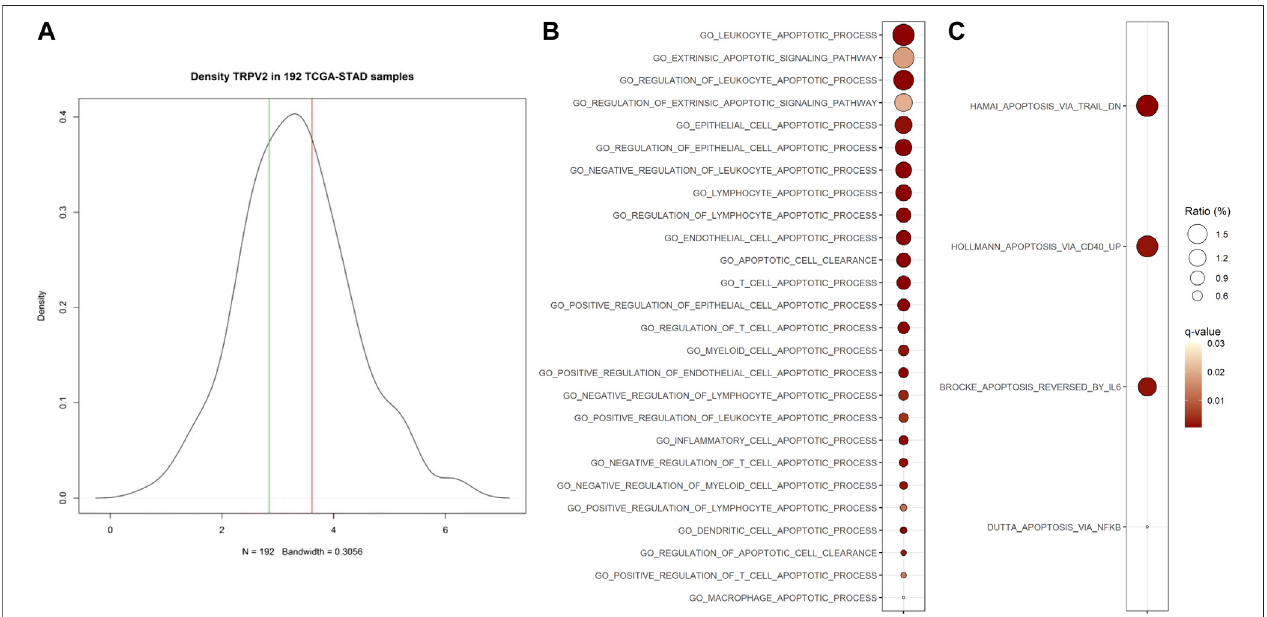
FIGURE 1| Association ofTRPV2 expression with apoptosis-related gene sets. (A) Distribution on TCGA-STAD GC samples based on TRPV2 expression. Green and red lines de fi ne the lower and upper tertiles, respectively. (B) and (C) Apoptosis-related Ontology and Canonical Pathways gene sets signi fi cantly enriched in samples characterized by high TRPV2 expression. Ratio indicates, among all DEGs, the percent of upregulated genes included in each gene set.